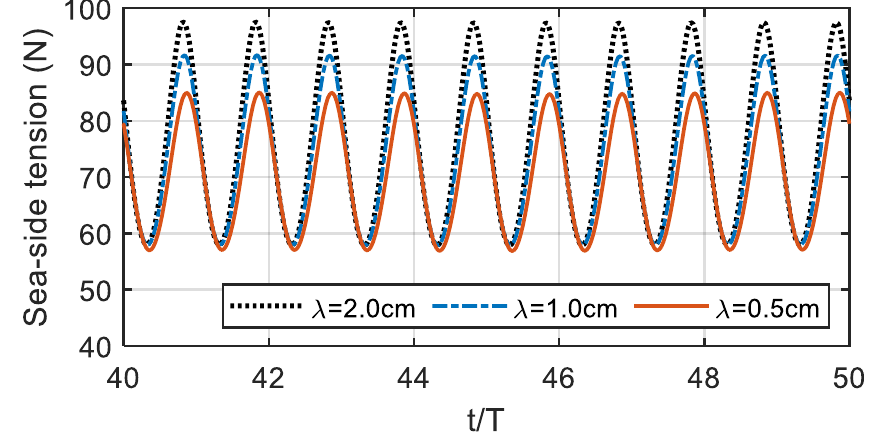
Figure 10. Variations in the sea-side tension for the platform with various fishnet mesh sizes ( H = 4 cm, T = 0.91 s, and σ 2 h / g = 3.9).